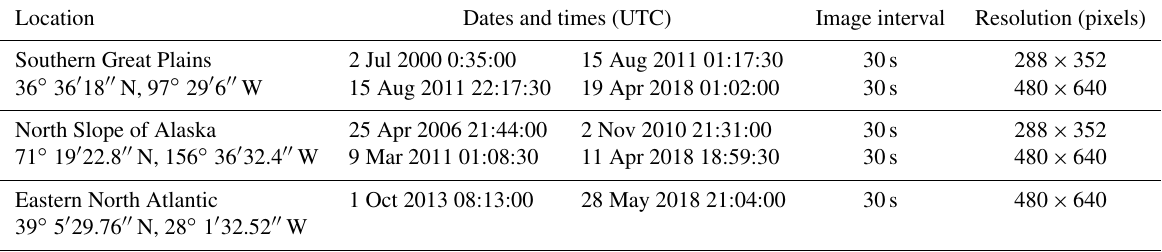
Table 1. TSI data set properties. Seed images for the algorithm were taken from all three locations. Data source: ARM (2000). Location Dates and times (UTC) Image interval Resolution (pixels) Southern Great Plains 2 Jul 2000 0:35:00 15 Aug 2011 01:17:30 30s 288 × 352 North Slope of Alaska